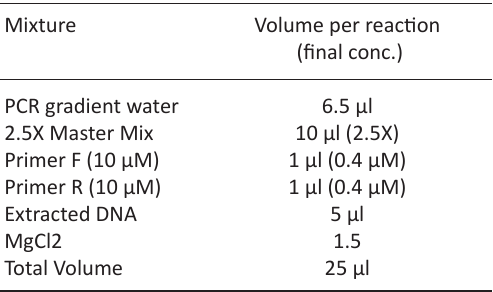
Table 2. Final PCR buffer total volume 25µl Mixture Volume per reaction (final conc.)